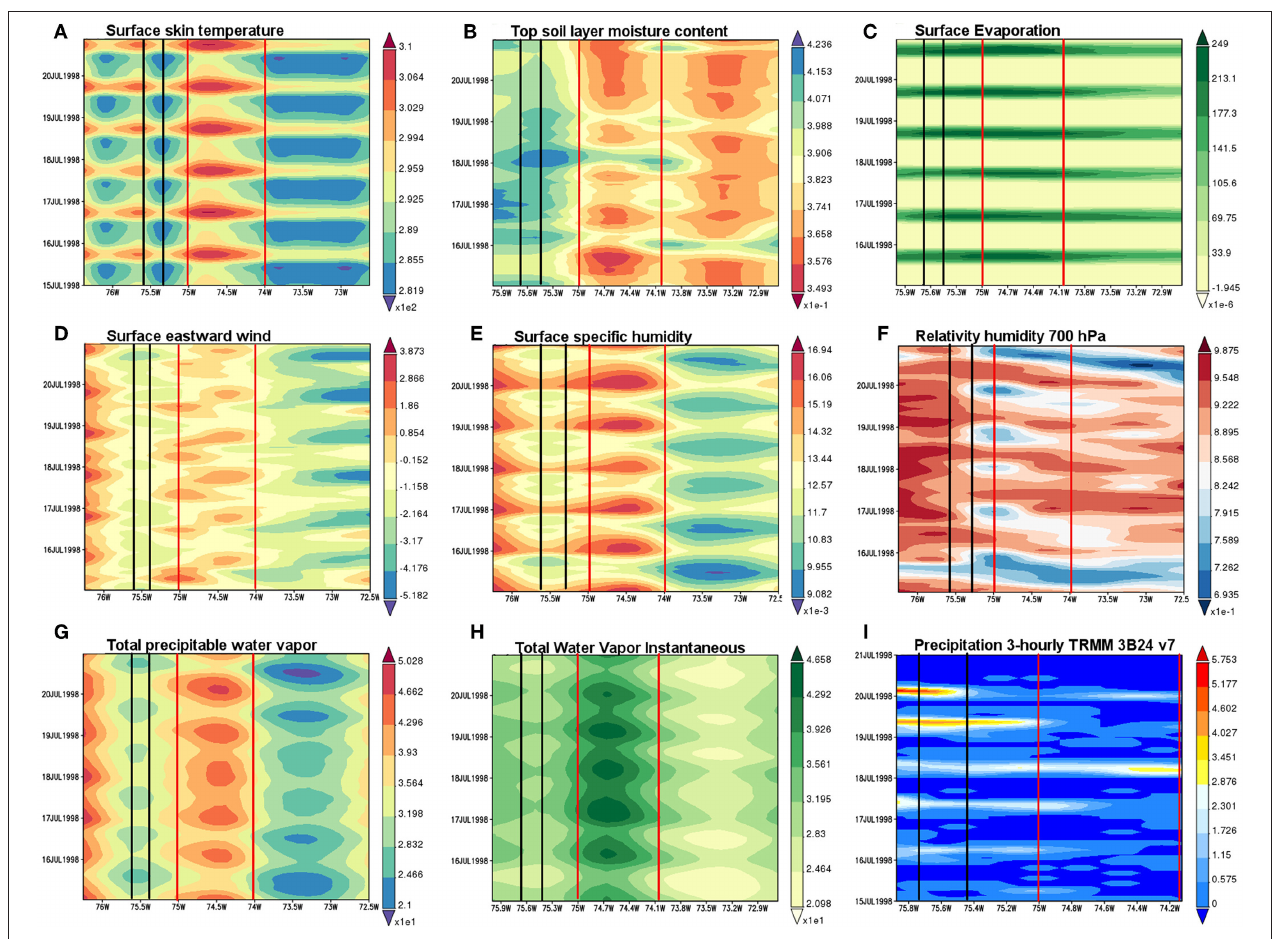
FIGURE 7 | Hovmöller time-latitude diagrams averaged over 5N to 6N for the 6-day period spanning between 15 and 21 July of 1998 with 3-h timesteps (A) Surface Skin temperature, (B) Top soil layer moisture, (C) Surface Evaporation, (D) Surface eastward wind, (E) Surface Specific Humidity, (F) Relative humidity at 700 hPa after moist (MERRA 2), (G) Total precipitable water, (H) Total water vapor, and (I) Precipitation (TRMM 3B42v.7). These diagrams were produced with the Giovanni online data system, developed and maintained by the NASA GES DISC ( Acker and Leptoukh, 2007). The Magdalena Valley (Aburrá Valley) location is enclosed in red (black)